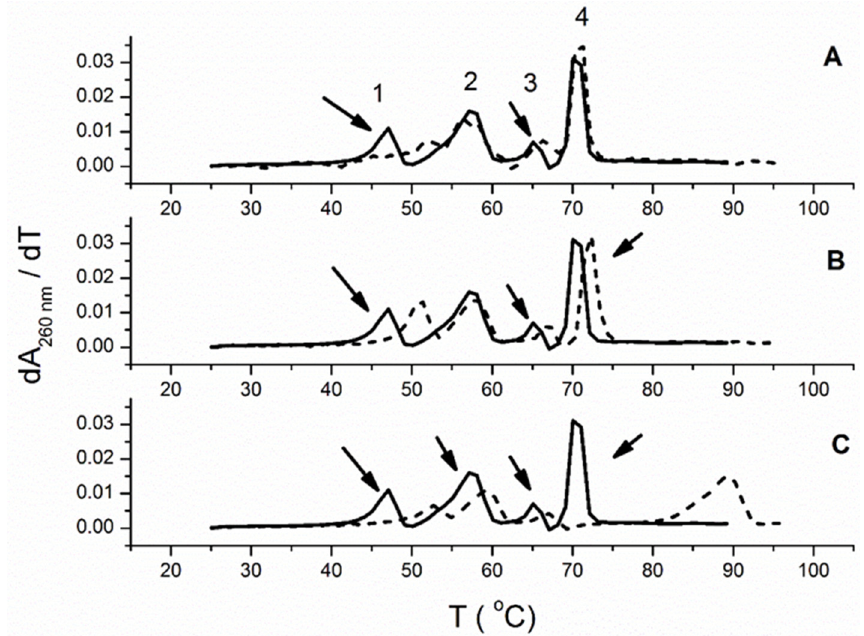
Figure 5. Melting profiles of polynucleotide mixtures (first derivative profile of absorbance versus temperature). Each panel shows the melting of a mixture of 4 polynucleotides: a DNA:RNA hybrid [poly dA − poly rU; peak 1], RNA [poly rA − poly rU; peak 2], an RNA:DNA hybrid [poly rA − poly dT; peak 3] and DNA [poly dA-poly dT; peak 4] as the solid black line ( − ). The concentration of each polynucleotide structure was 20 µ M (bp); total polynucleotide concentration is 80 µ M (bp). The dashed line (- - -) in each panel shows the effect of the addition of ligand. ( A ) 6 ( B ) 5 ( C ) 1 all at 2 µ M (50 mM sodium cacodylate buffer, 50 mM NaCl, and 1 mM EDTA). Table 3. The ∆ T m a values ( ◦ C) of studied mixture of four polynucleotides (poly rA − poly dT, poly rA − poly rU, poly dA − poly rU, and poly dA-poly dT) b upon addition of ratio r = 0.025 c of 1 , 5 , and 6 d . ∆ T a m Polynucleotide